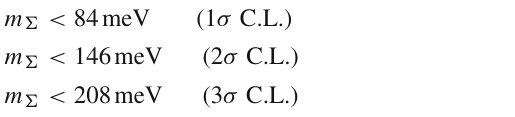
Fig. 10 Plot showing the variation of trino mass ( m 1 for NH, m 3 for IH) (cid:2) m i = m 1 + m 2 + m 3 < 0 . 12 eV. Figure 10 which is